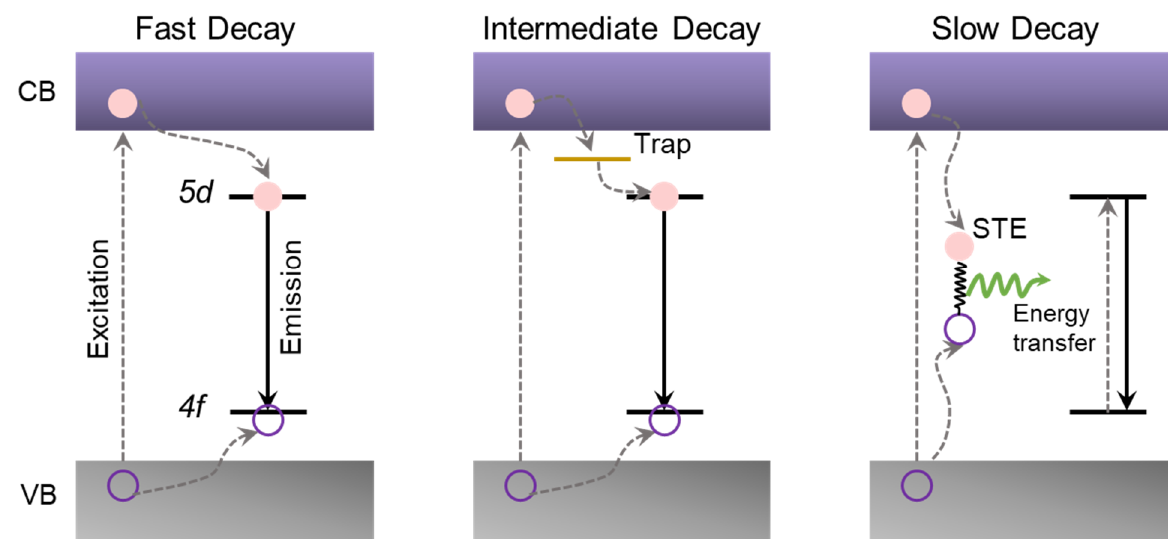
Figure 9. Schematic illustration of three luminescence processes characterized by different decay rates. Reproduced from Reference [147] with permission.